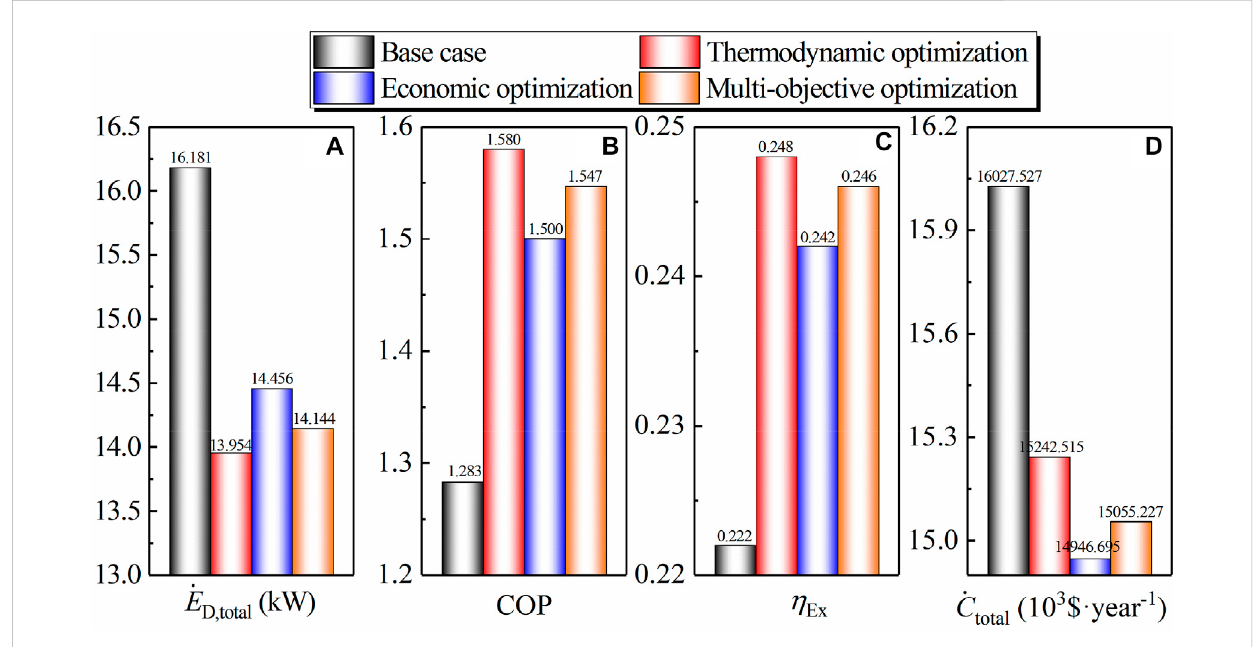
FIGURE 12 Comparison of Exergy destruction, COP, exergy ef fi ciency and annual total